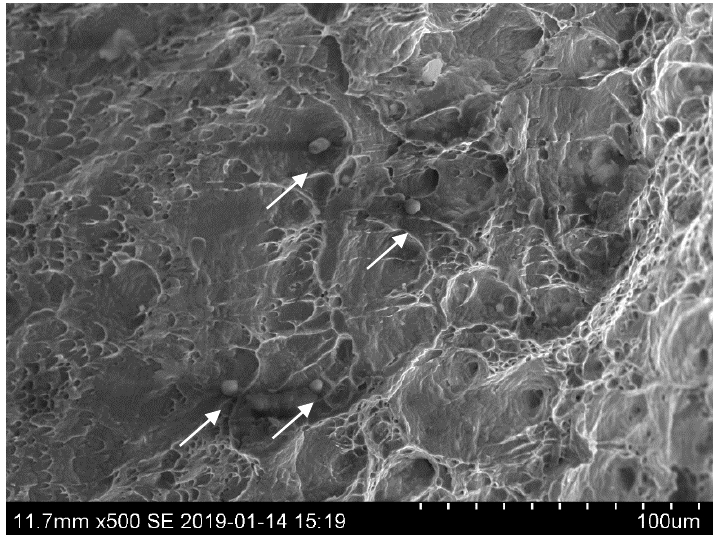
Figure 9. Oxide NMIs found in the large dimples on the fracture section of the chips obtained during machining of the 316L + Ca steel.